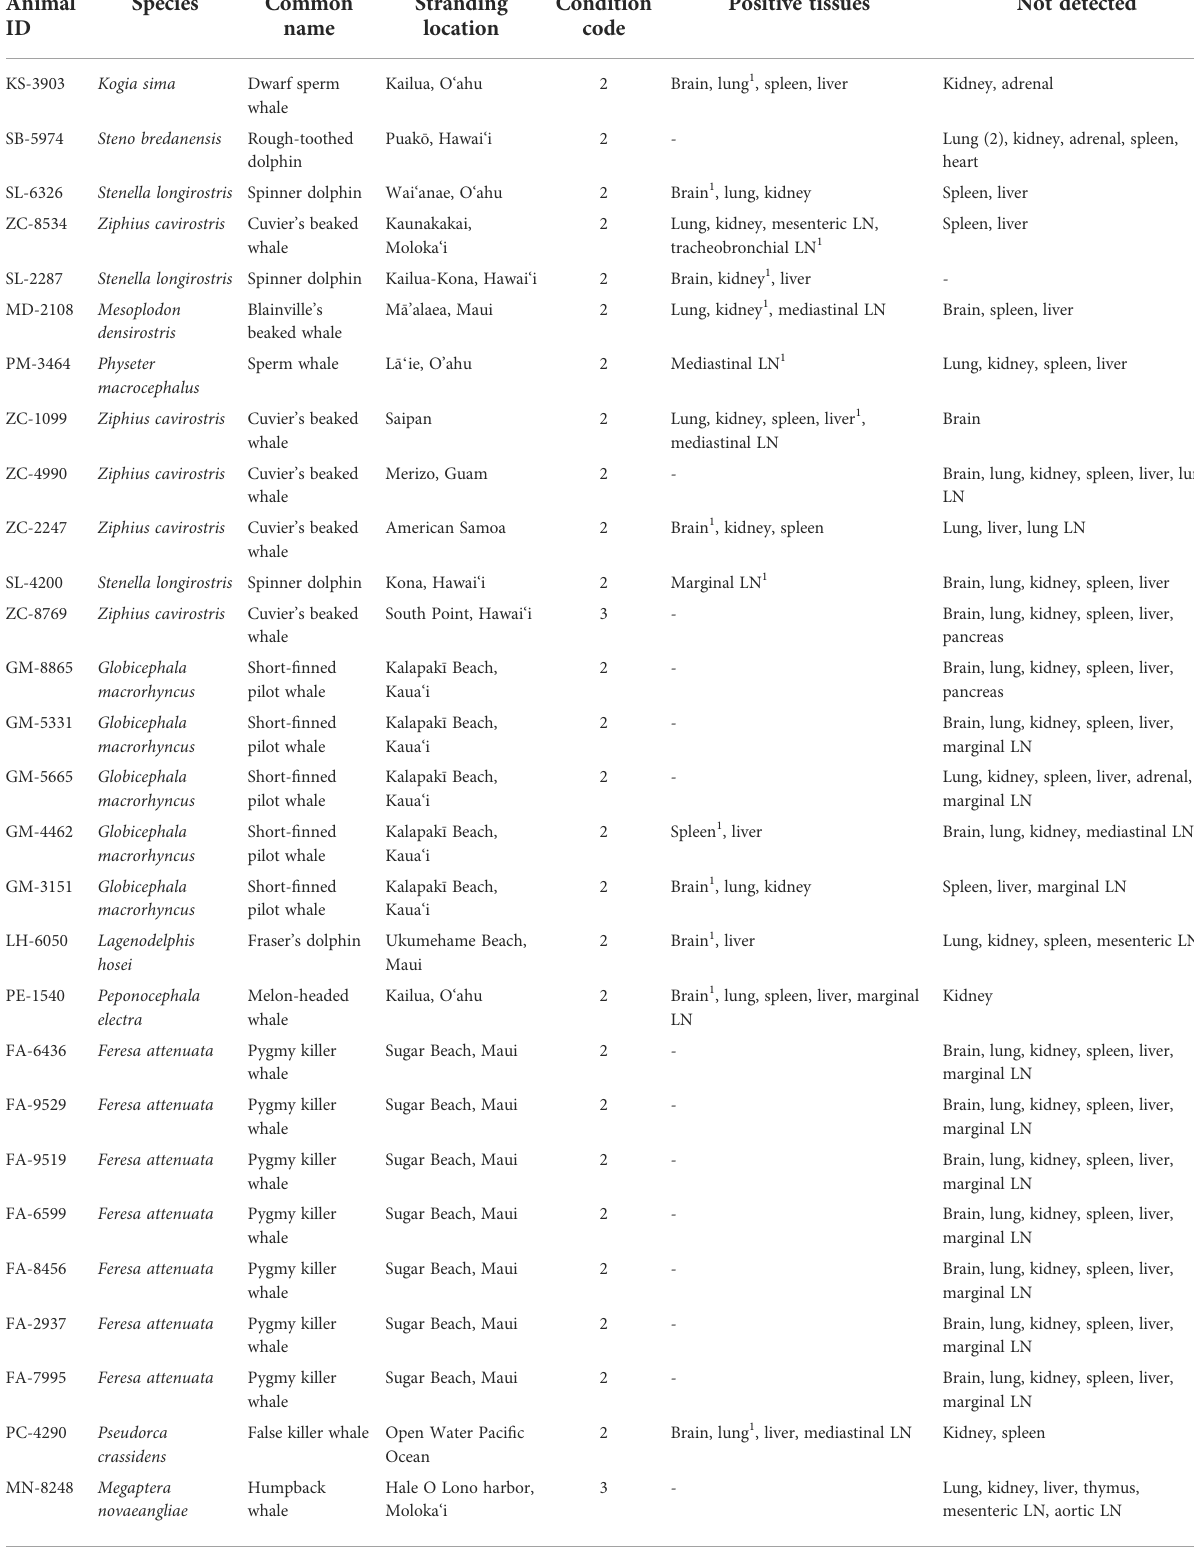
TABLE 1 Stranded cetacean cases tested for presence of beaked whale